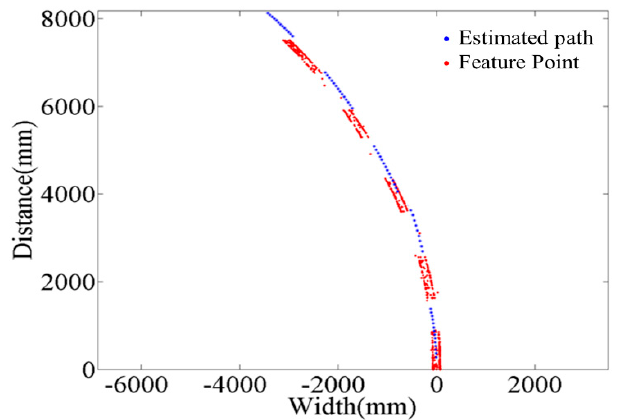
Figure 17. Application of the curvature algorithm.